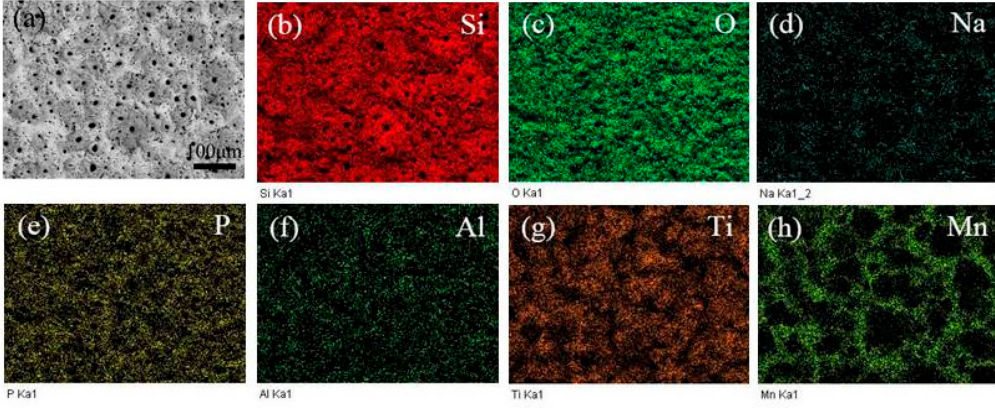
Figure 5. EDX mapping results of the sample prepared with 0.8 g/L concentration of KMnO 4 : ( a ) SEM morphology; ( b ) Si; ( c ) O; ( d ) Na; ( e ) P; ( f ) Al; ( g ) Ti and ( h ) Mn.